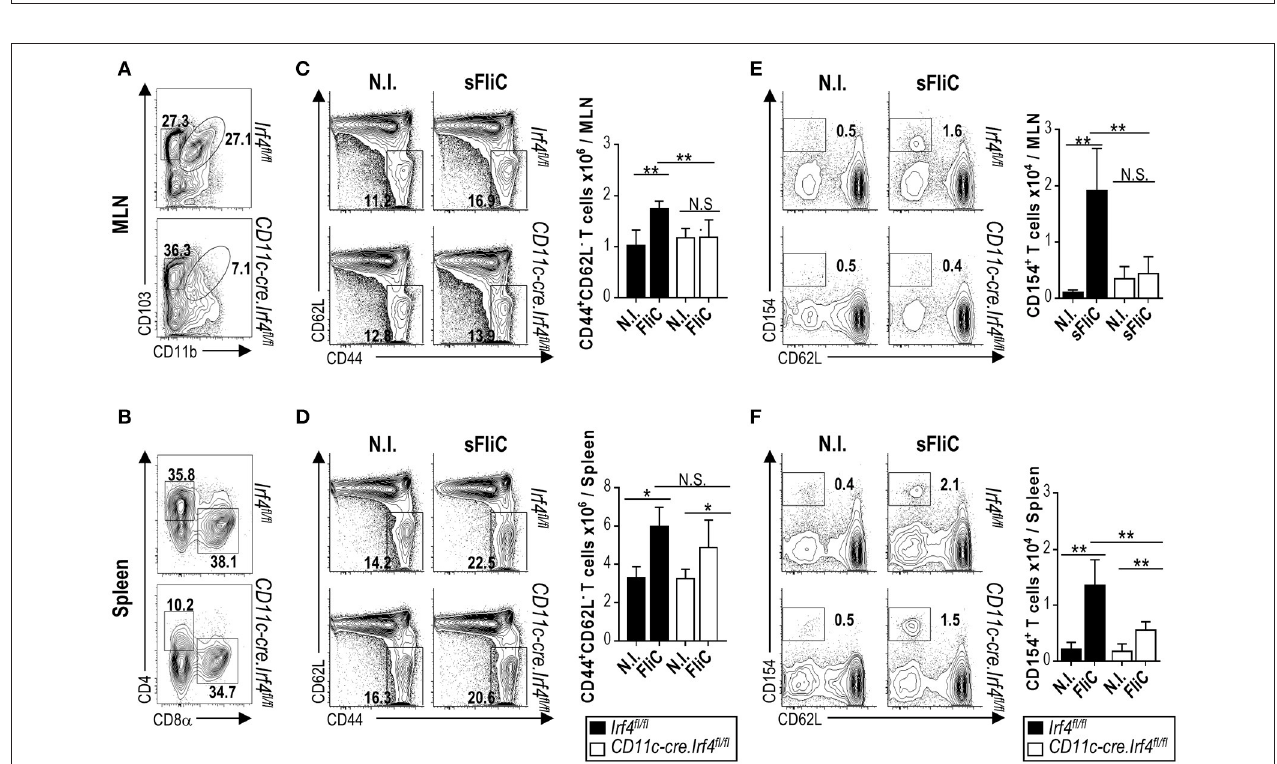
FIGURE 1 | T, T zone; B, B zone. (B) WT or NAIP5 − / − mice were immunized i.p., with sFliC and absolute numbers of MLN CD103 + cDC2s were evaluated 24h later, alongside non-immunized (N.I.) mice. (C) Wild-type (WT) or TLR5 − / − mice were immunized i.p. with sFliC and splenic cDCs (Lin − MHC-II hi CD11c hi ) were evaluated 24h later, alongside non-immunized (N.I.) mice. Representative flow cytometry plots (including percentages) of cDC2s (Lin − MHC-II hi CD11c hi CD11b + ) are shown with adjacent graphs of absolute numbers. Representative photomicrographs of spleen sections stained for CD11c; blue, Dec205; green, DCIR2; red, and IgM; white (scale bar = 100 µ m). Zoom-in insets (white boxes) show the differential location of cDC1s (Dec205 + ) in the T zone and cDC2s (DCIR2 + ) in the bridging channels. Data shown as mean + s.d. of 4 mice and are representative of 3 independent experiments. ** P < 0.001, by two-way analysis of variance (ANOVA) N.S., not significant.